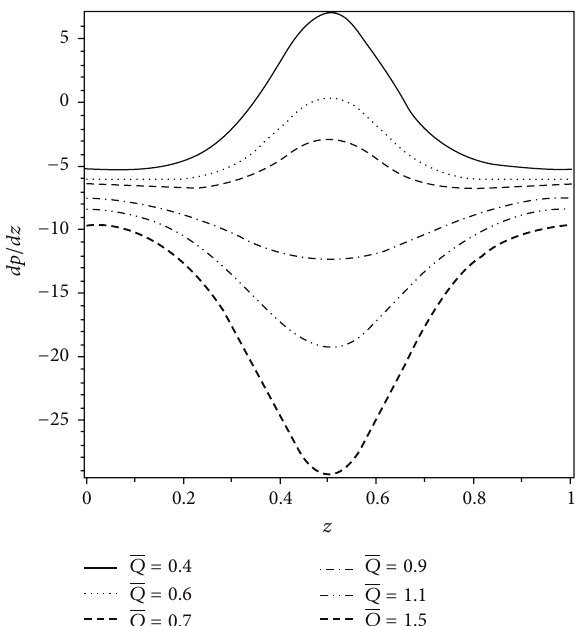
Figure 7: Variation of axial pressure gradient 𝑑𝑝/𝑑𝑧 for different values of 𝑄 when 𝐻 𝑝 = 0.05 , 𝜀 = 0.25 , 𝛼 = 0.4 , and 𝛽 = 0.4 .